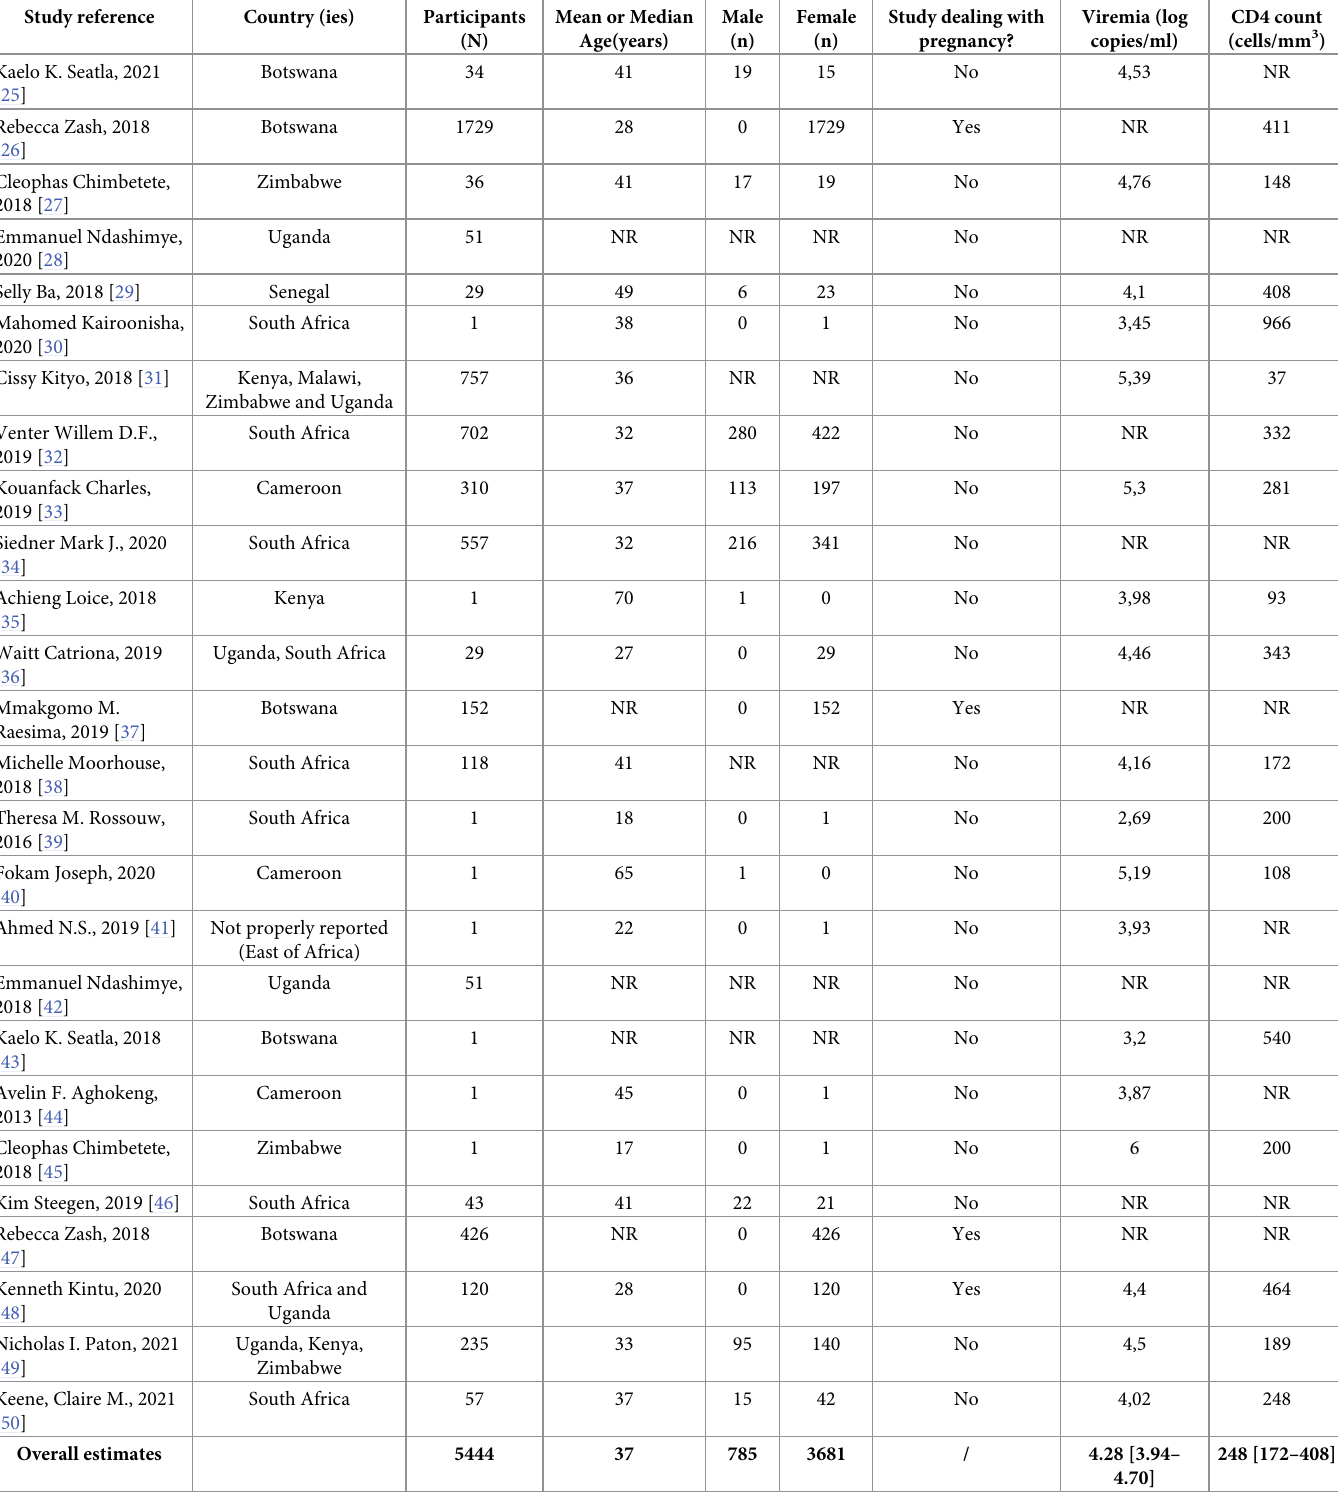
Table 1. Baseline characteristics of study